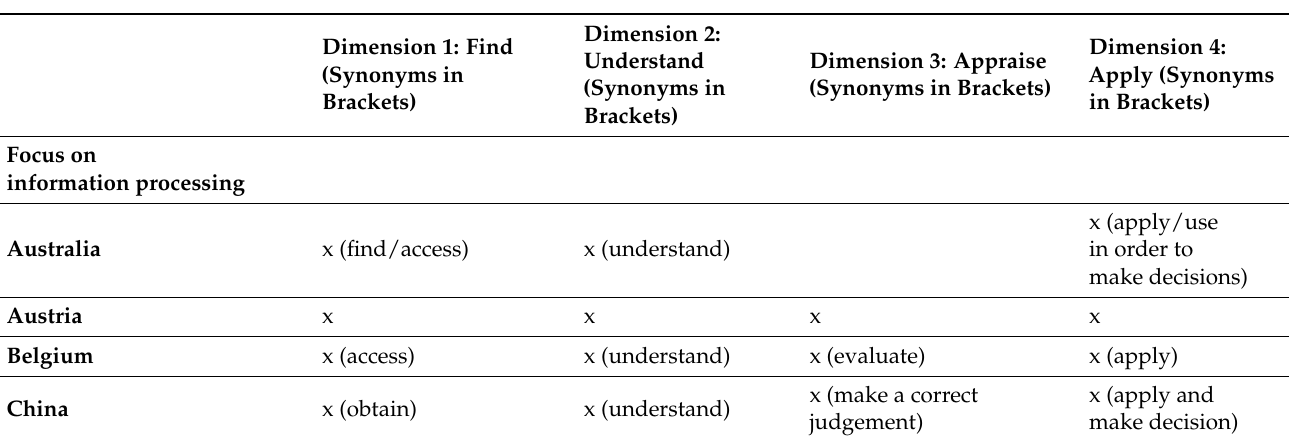
Table A1. Health Literacy at the individual level (focus on information